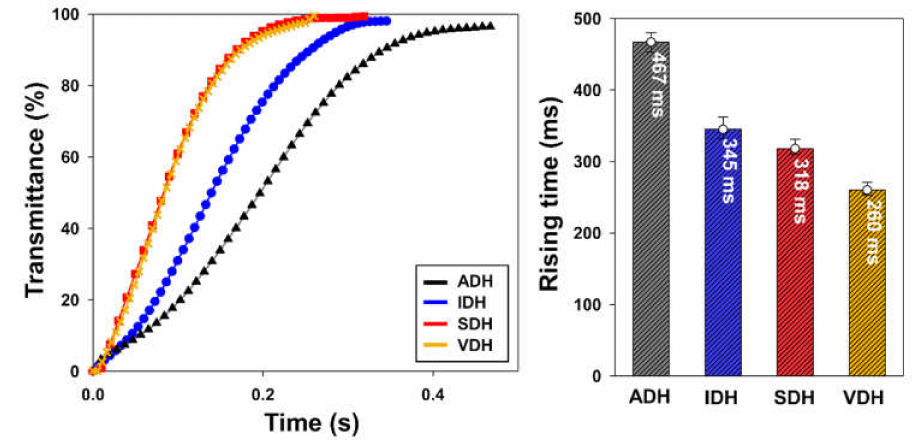
Figure 9. Response time curves for various epoxy resin systems and their rising response